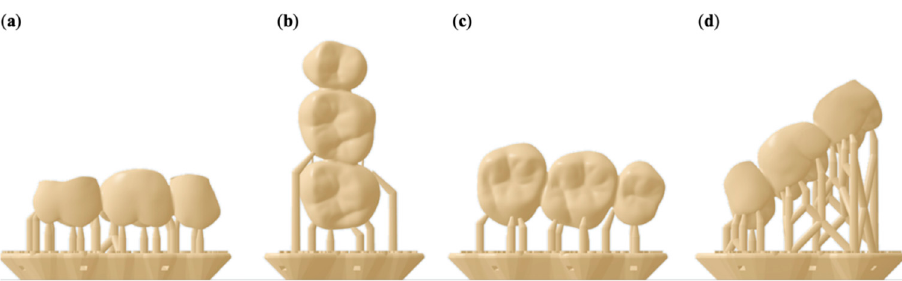
Figure 4. Illustration of the FDP specimens in an ( a ) occlusal, ( b ) vertical, ( c ) palatal, and ( d ) diagonal printing orientation including support structures and rafts.